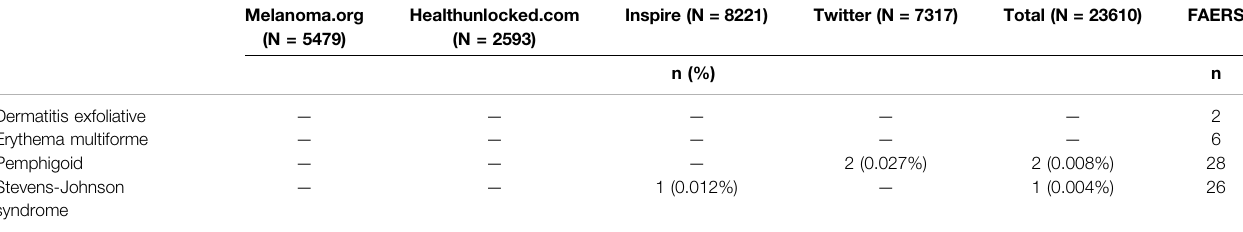
TABLE 4 | Adverse events of interest (by MedDRA preferred term) identi fi ed in posts mentioning pembrolizumab. Melanoma.org (N =